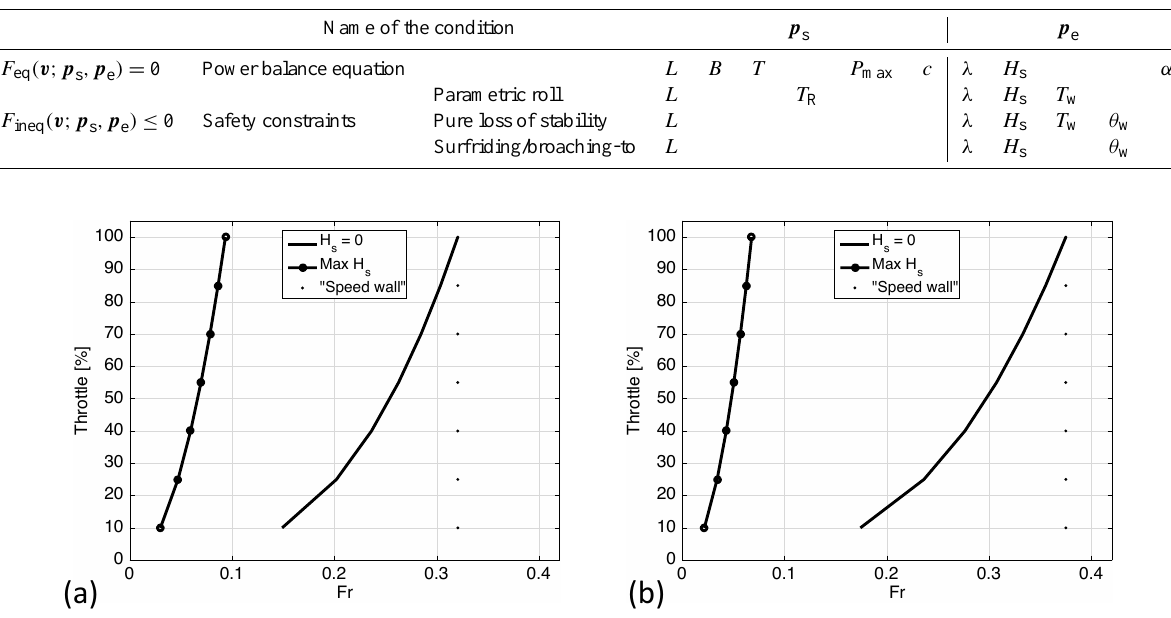
Figure 5. Engine throttle needed for sustaining a given Fr , in calm water resistance only (“ H s (“max H s ”, i.e. at maximum significant wave height seen in Fig. 4). Throttle values correspond to those of Table 3. Panel (a) and (b) refers to ship parameters for vessel V1 and V2 in Table 5,